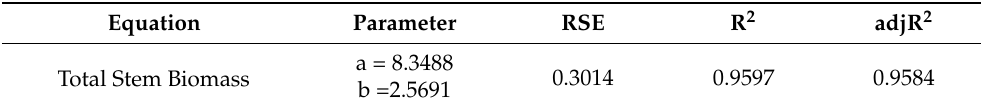
Table 1. Parameter values, residual standard error, R 2 , and adjusted R 2 for total stem biomass estimation based on